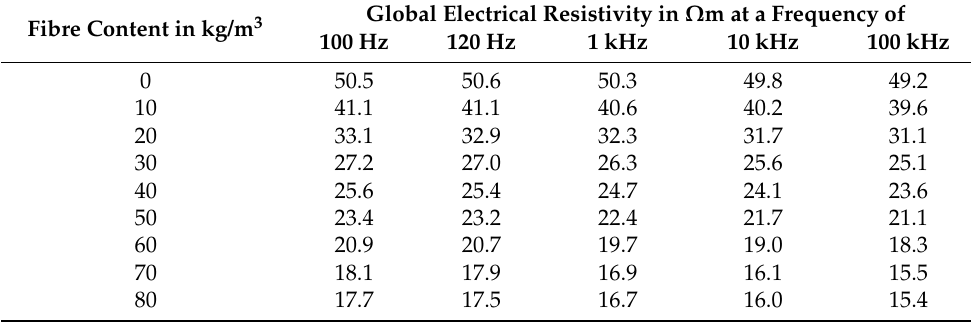
Table A11. Results of the resistivity measurements of the concrete mixture 32-55-300-00.